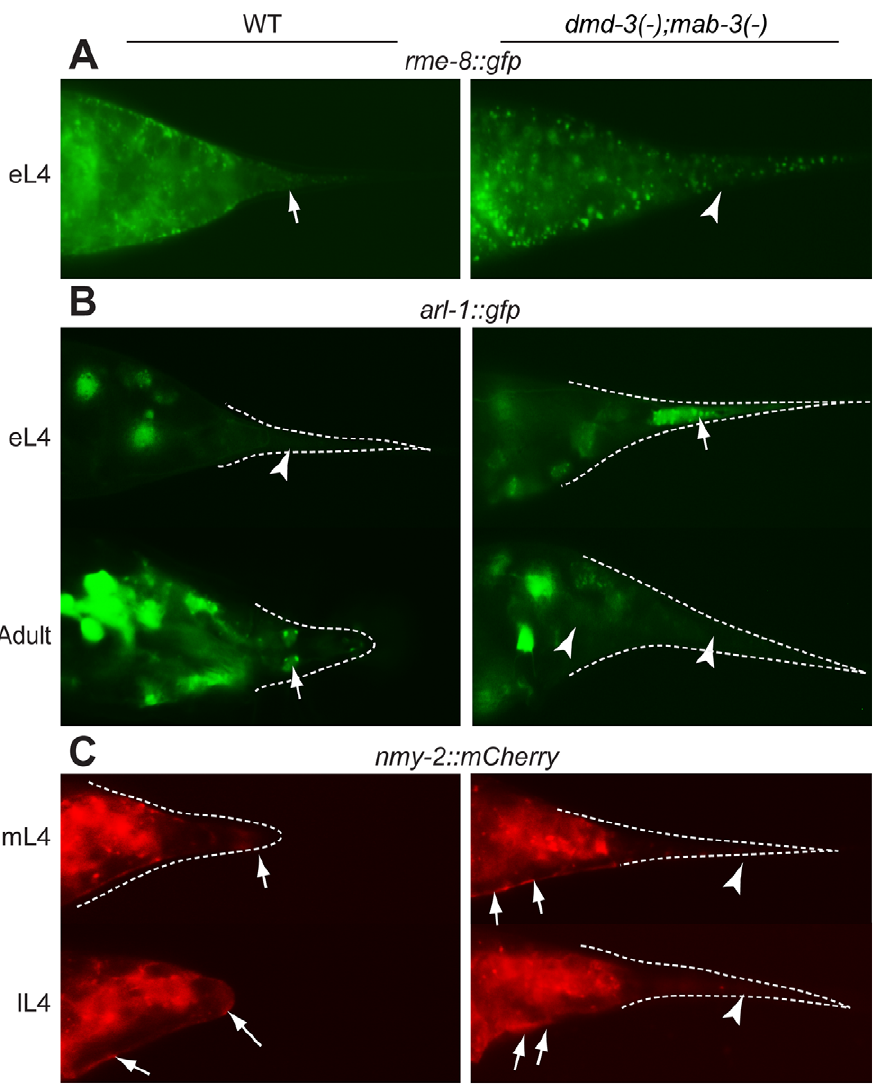
Figure 7. Cellular processes controlled by DMD-3 and MAB-3. Expression patterns of translational fusions are shown for wild-type males (left side of each panel) and mab-3(e1240);dmd-3(ok1327) mutant males (right side of each panel). (A) DMD-3 and MAB-3 regulate RME-8 localization but not expression. In wild-type animals, RME-8::GFP localizes as discrete puncta to the cell cortex where the tail tip cells are detaching from the cuticle (arrow), but is dispersed and cytoplasmic (arrowhead) in mab-3(e1240);dmd-3(ok1327) mutants. (B) In early L4, ARL-1::GFP shows very low levels of expression in wild-type males (arrowhead) but bright expression in hyp10 (arrow) in mab-3(e1240);dmd-3(ok1327) males. In adults, ARL-1::GFP is expressed in tail neurons in wild-type males (arrow points to phasmids), but not in mab-3(e1240);dmd-3(ok1327) males (arrowheads). (C) In wild-type males, NMY-2::mCherry localization is focused to a cap at the posterior end of the tail tip during rounding and to the region along the ventral edge where the tail tip cells are detaching from the cuticle (arrows). In mab-3(e1240);dmd-3(ok1327) animals, localization to the ventral surface still occurs (arrows), but localization to the posterior end of the tail is not observed (arrowheads).